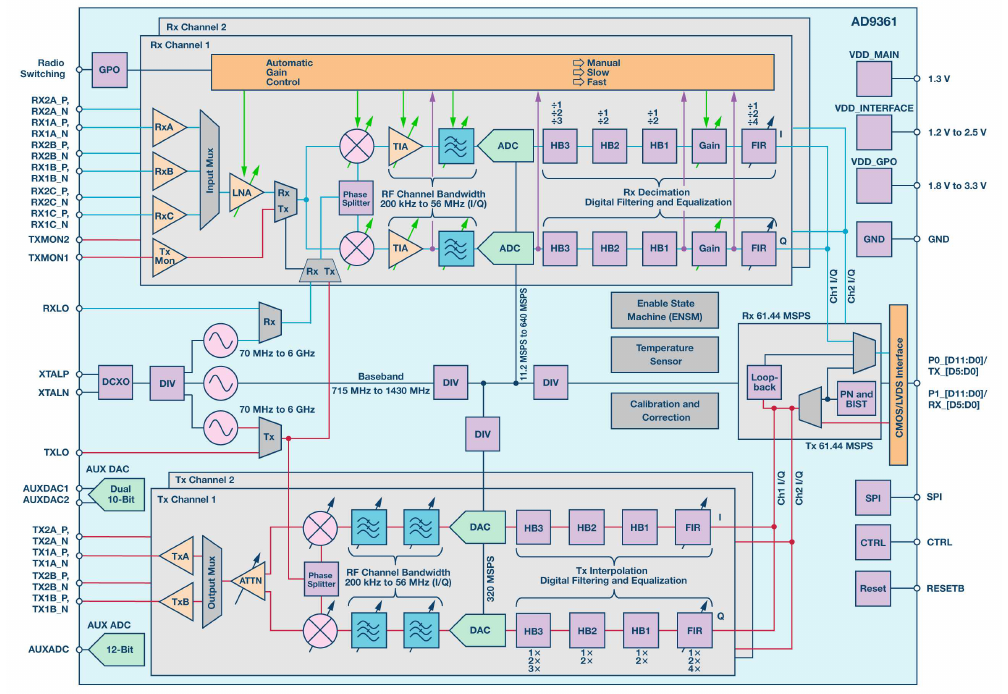
Figure 1. AD9361 block diagram